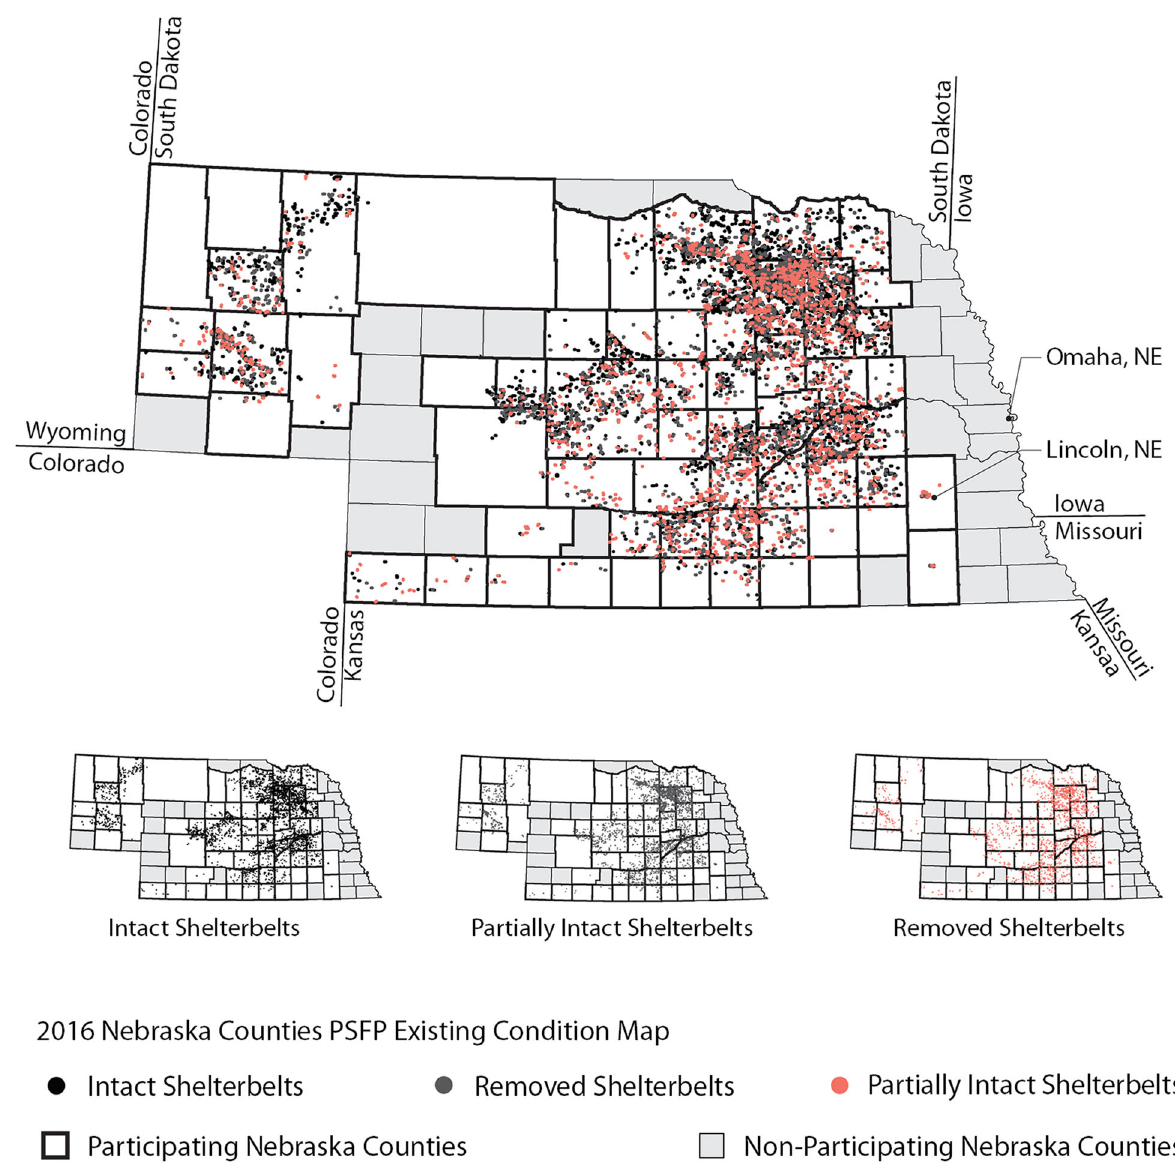
Fig. 8 2016 Nebraska PSFP Existing Conditions Map. Map illustrating the status of every shelterbelt planted across the state of Nebraska (Source: the authors)